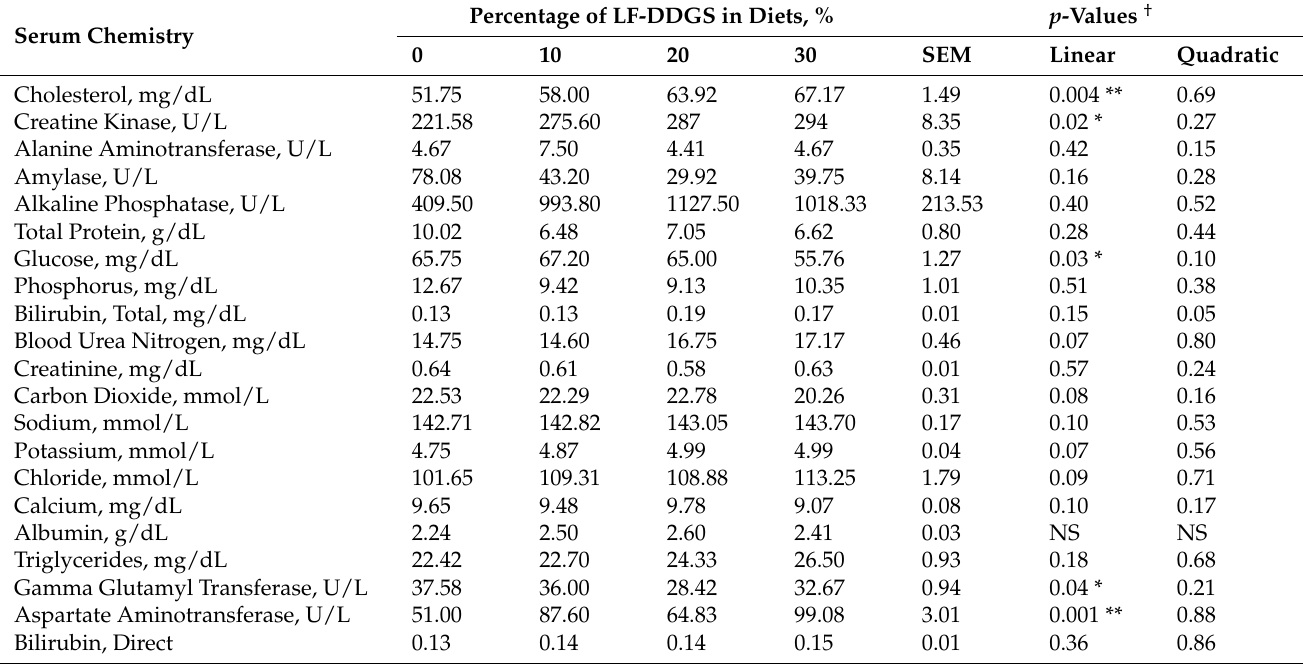
Table 4. Select-serum biochemistry profile of the castrated male goats fed diets with different percentages of low-fat distillers dried grains with solubles (LF-DDGS) for 84